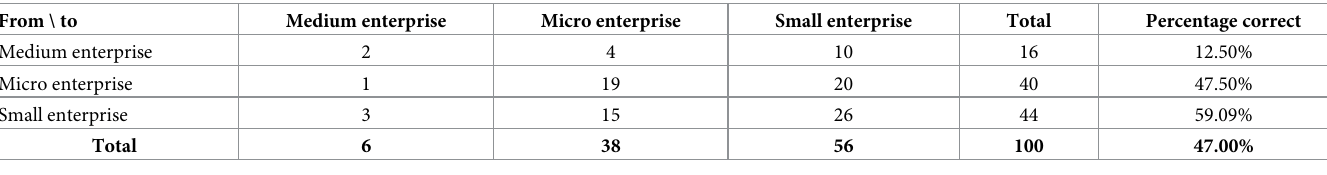
Table 11. Confusion matrix of different groups of interpersonal trust. From \